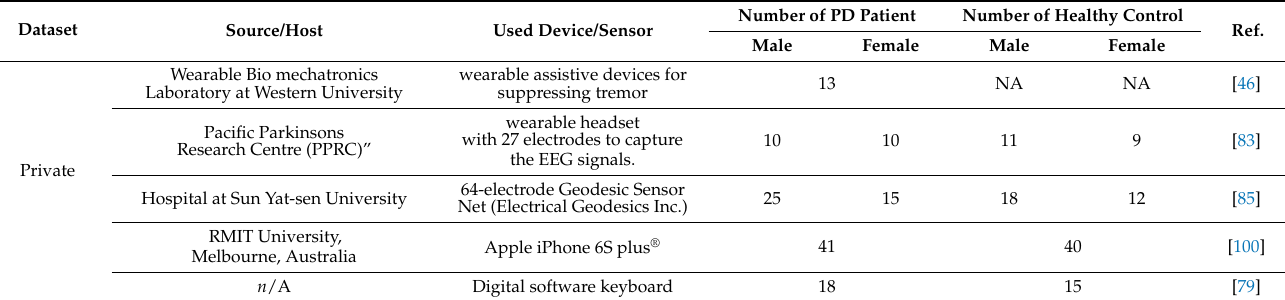
Table 5. Private dataset